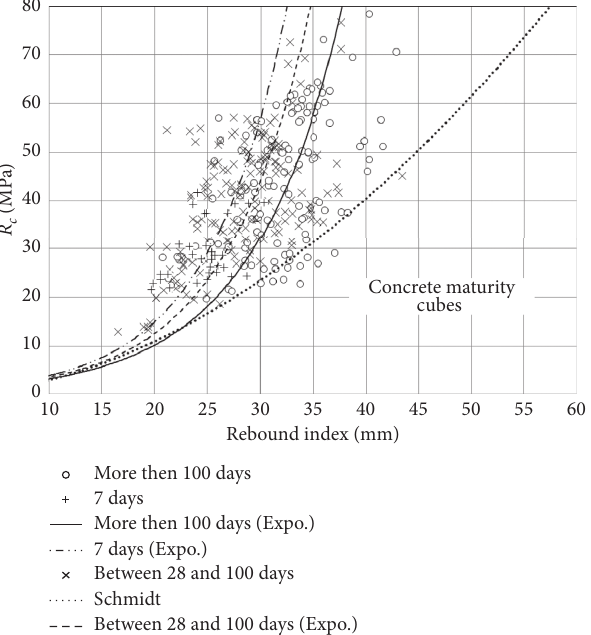
Figure 9: Calibration curve for different concrete ages after casting (standard curing conditions). Calibration curve: R c � e a RI ; RI � rebound index; a ∈ [0.12, 0.14]; R 2 � [0.61, 0.81]. Inside any dataset, C.o.V. � 13% for < 100-day cubes; C.o.V. � 22% for cubes ∈